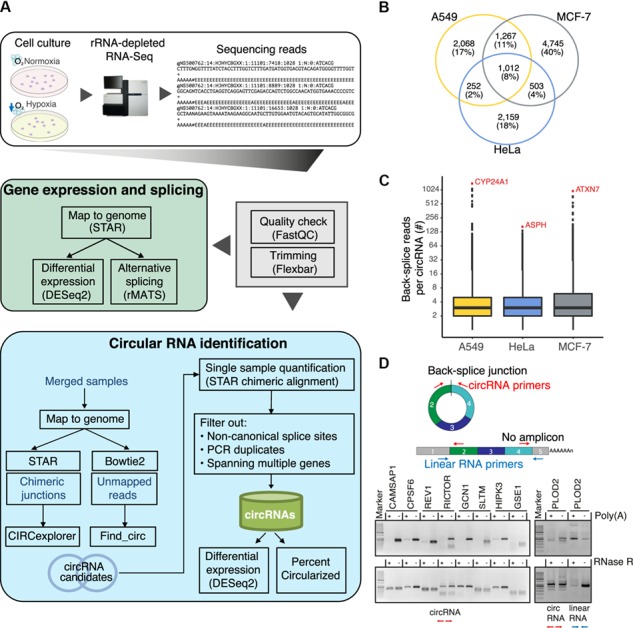
Identification and validation of circRNAs. (A) Consolidated pipeline for circRNA identification and expression analysis from rRNA-depleted RNA-Seq data of normoxic and hypoxic cancer cells. The initial circRNA predictions by find_circ (Memczak et al., 2013) and CIRCexplorer (Zhang et al., 2014) are combined and rigorously filtered to obtain a comprehensive catalog of circRNAs. In parallel, linearly mapped reads are used for the analysis of differential gene expression and alternative splicing. (B and C) Analyses of the complete catalog of 12006 circRNAs (≥2 supporting back-splice reads in any sample). (B) Venn diagram showing the overlap of circRNAs identified in A549, HeLa, and MCF-7 cells. (C) Boxplot showing the number of back-splice reads from each cell line. circRNAs hosted by the genes CYP24A1 (circBase ID hsa_circ_0060927), ASPH (hsa_circ_0084615), and ATXN7 (hsa_circ_0007761) were the top expressed circRNAs in A549, HeLa, and MCF-7 cells, respectively. (D) Validation of circularity for 9 circRNAs in HeLa cells. Due to their lack of a poly(A) tail and free ends, circRNAs are only amplified from the polyA(−) fraction and resistant to the exonuclease cleavage (RNase R). Top: schematic of oligonucleotides used in RT-PCR to amplify the circRNA (red) or the related linear transcript isoform (blue). Bottom: RT-PCR products for 9 circRNAs using divergent oligonucleotides after polyA(+) selection or RNase R treatment. Oligonucleotides amplifying the linear PLOD2 transcript were used as control.